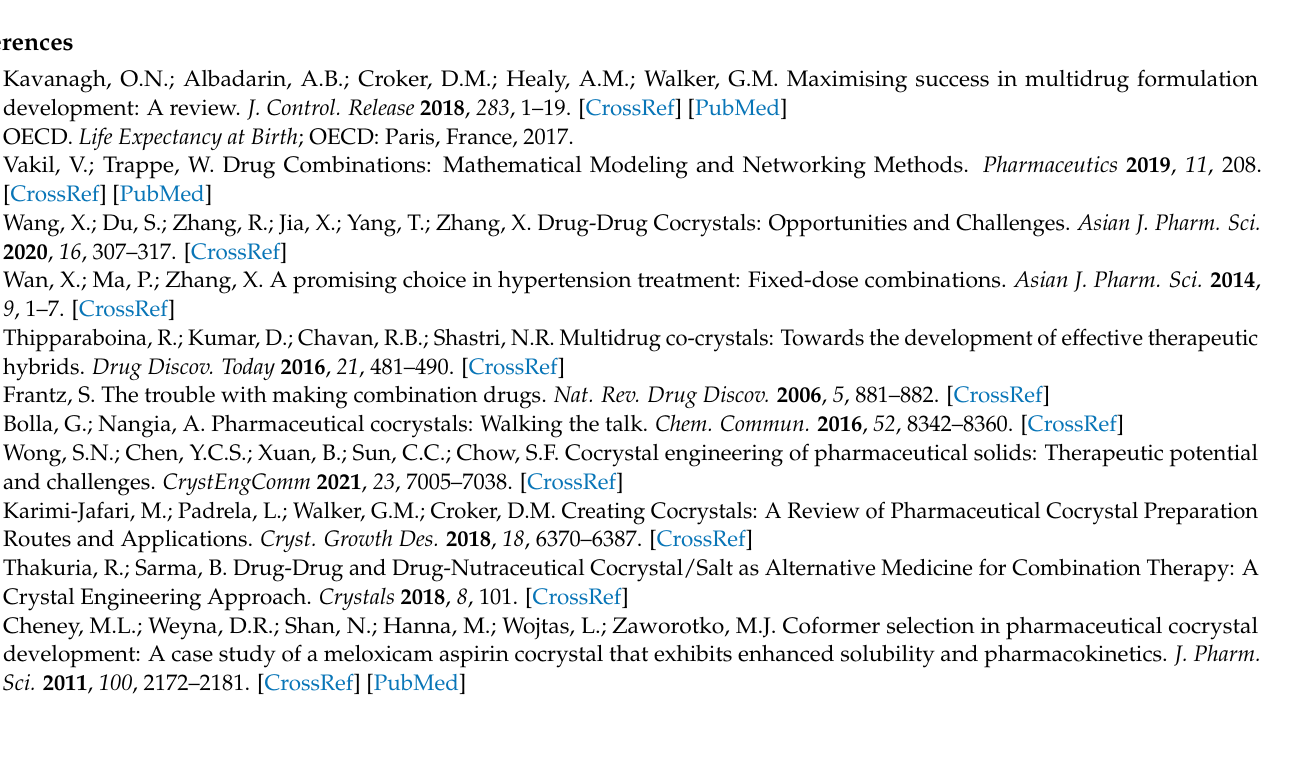
Figure S27: Comparison of PXRD patterns for INZ (red), IBU-ZnO grinding result in 2:1 (blue) and IBU-ZnO-INZ three-component grinding results in 2:1:1 (green) and 2:1:2 (orange) ratios; Figure S28: Comparison of PXRD patterns for AMI (red), IBU-ZnO grinding result in 2:1 (blue) and IBU-ZnO-AMI three-component grinding results in 2:1:1 (green) and 2:1:2 (orange) ratios; Figure S29: Compari- son of PXRD patterns for MN (red), PABA-ZnO grinding result in 2:1 (blue) and PABA-ZnO-MN three-component grinding results in 2:1:1 (green) and 2:1:2 (orange) ratios; Figure S30: Comparison of PXRD patterns for NC (red), PABA-ZnO grinding result in 2:1 (blue) as well as PABA-ZnO-NC three-component grinding results in 2:1:1 (green) and 2:1:2 (orange) ratios; Figure S31: Comparison of PXRD patterns for INC (red), PABA-ZnO grinding result in 2:1 (blue) as well as PABA-ZnO-INC three-component grinding results in 2:1:1 (green) and 2:1:2 (orange) ratios; Figure S32: Comparison of PXRD patterns for AMI (red), PABA-ZnO grinding result in 2:1 (blue) as well as PABA-ZnO-AMI three-component grinding results in 2:1:1 (green) and 2:1:2 (orange) ratios; Figure S33: VT-PXRD analyses of Zn(IBU) 2 (INC) 2 (H 2 O) 2 taken at 30 ◦ C (blue) and 140 (green). The simulated PXRD patterns of the hydrated (orange) and the anhydrous (red) complexes are given for